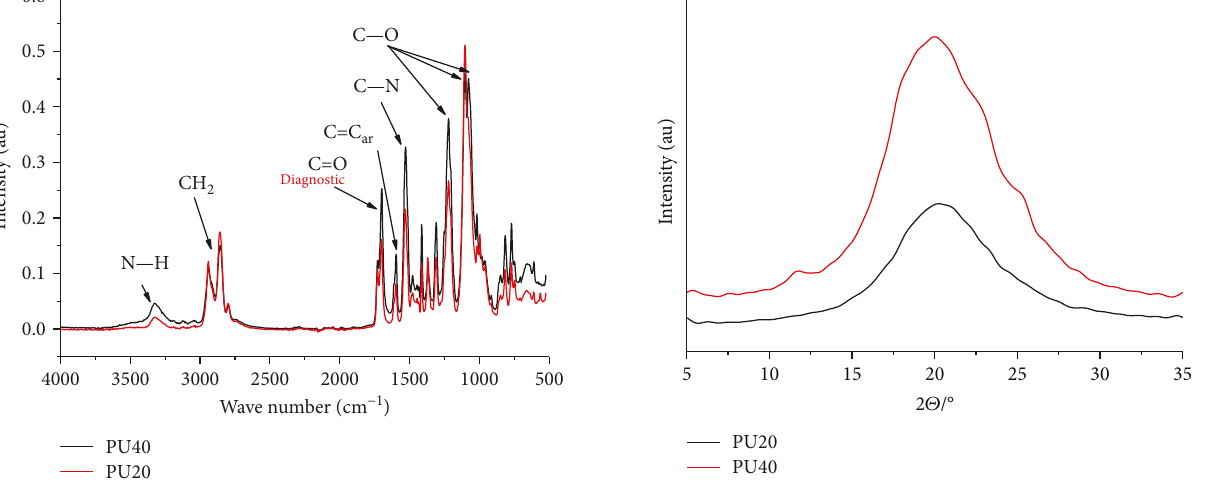
Figure 4: XRD di ff ractograms for nonmodi fi ed PU matrices with di ff erent hard segment ratios. Table 1: Phase transitions parameters for nonmodi fi ed PUs.